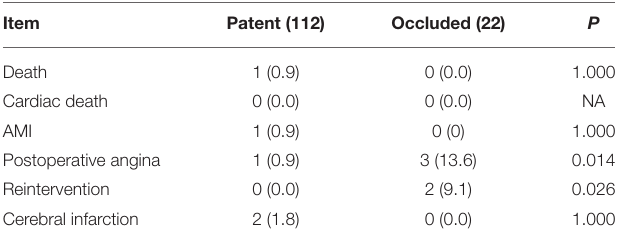
TABLE 4 | Details of CTA examination at approximately one year after